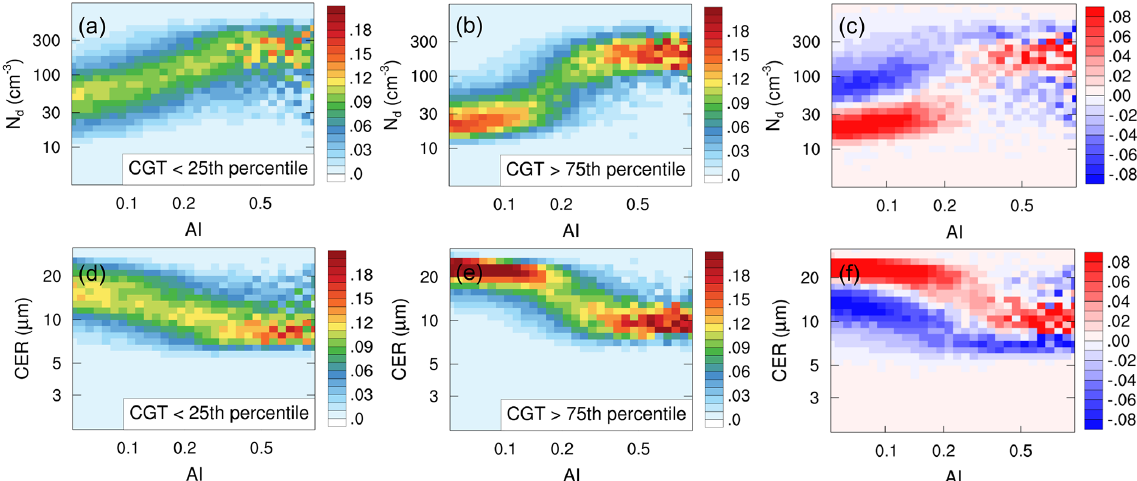
Figure 3. Joint histograms between AI and N d (CER) created for weak and strong updraft conditions, as defined by the lowest and highest CGT quartiles, respectively. The difference plots between strong and weak cases are shown at the end of each row. The histograms are normalized so each column sums to 1 such that the histograms show the probability of observing a specific N d (CER) given a certain